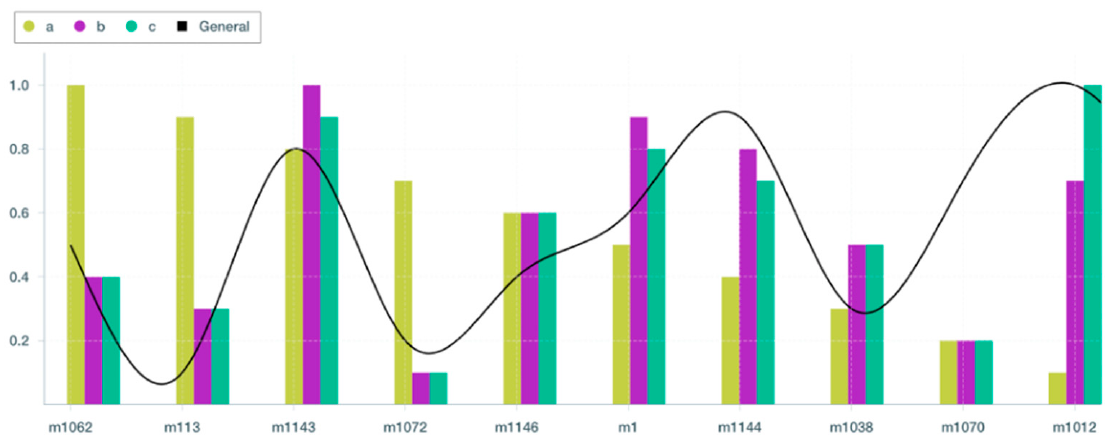
Figure 7. Ranking of top resources selected for Task 224334 with varying weight preferences.